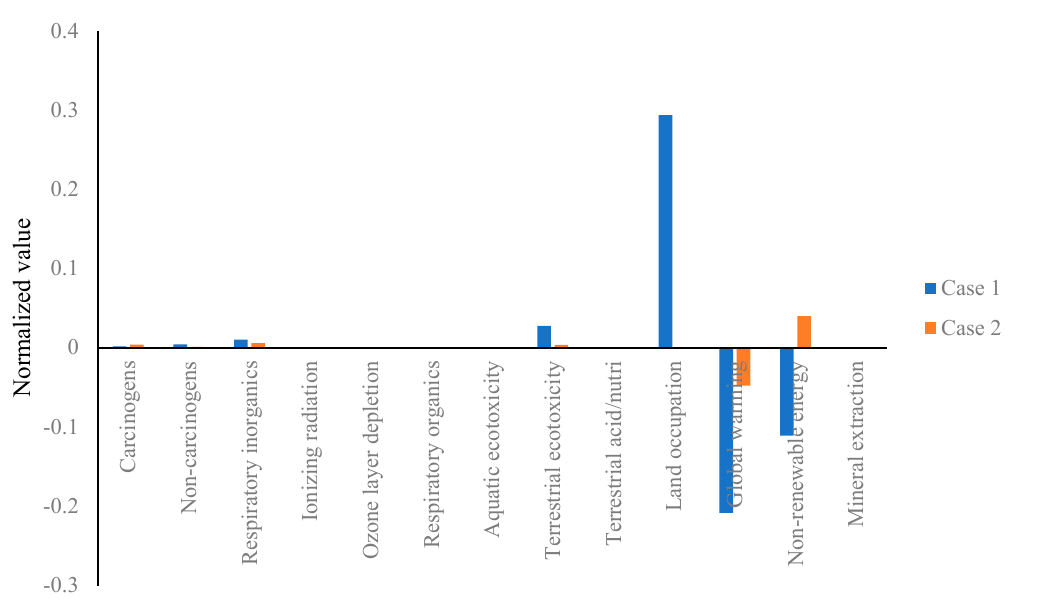
Figure 2. Normalized impact categories in each case.